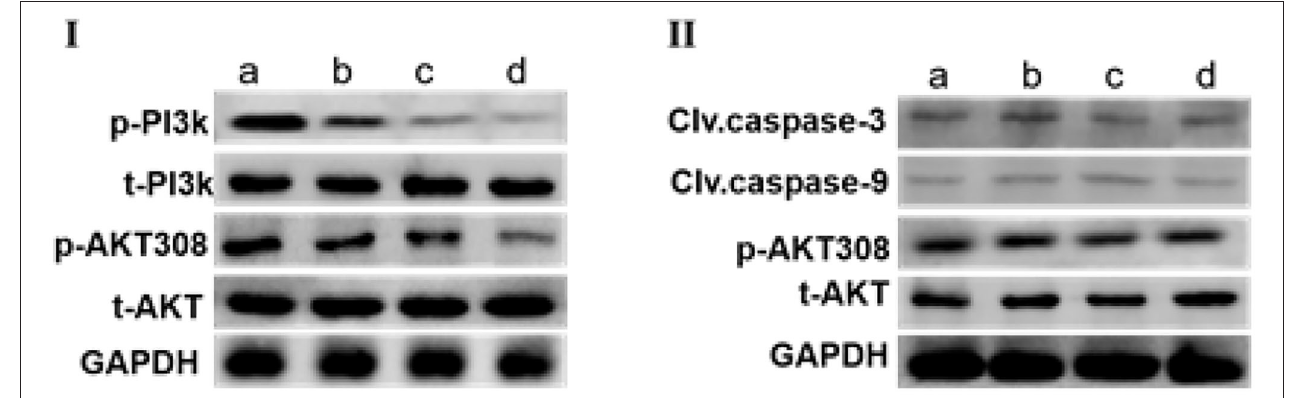
FIGURE 5 | SCIP promotes the apoptosis of MCF-7 by activation of PI3K/AKT signaling pathway. (I) MCF-7 cells were treated with various concentrations of SCIP (0, 27.8, 83.3, and 250 µ g/ml) for 24h, then collected the cells to extract the total proteins and western blots were used to investigate the expression of total AKT (t-AKT), p-AKT, t-PI3k, and p-PI3k, respectively ( n = 3). (II) MCF-7 cells were pretreated with wortmannin for 1h, then incubated with SCIP (0, 27.8, 83.3, and 250 µ g/ml) for 24h. After treatment, the MCF-7 cells were harvested to detect the expression of t-AKT, p-AKT, Clv.caspase-9, and Clv.caspase-3 ( n =